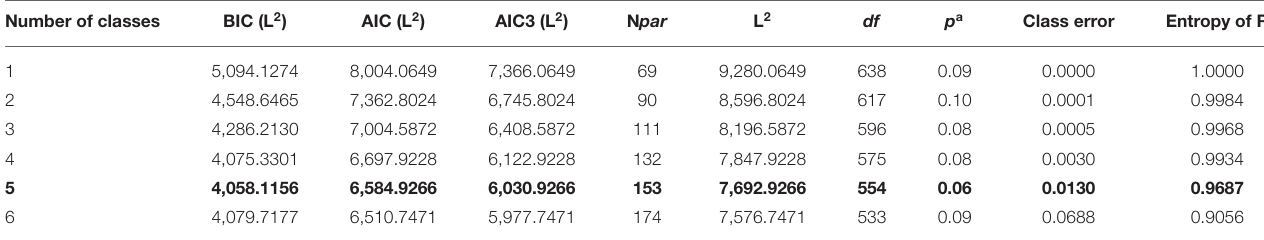
TABLE 3 | Nested model comparisons for latent classes. Number of